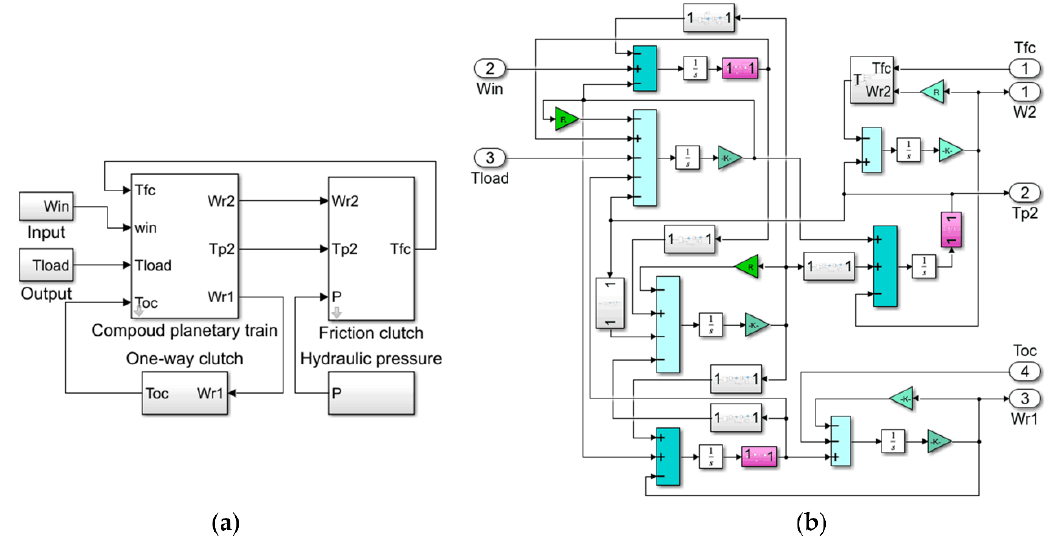
Figure 15. Simulation scheme using MATLAB Simulink: ( a ) double-row double planetary gearbox shift model, ( b ) compound planetary train.